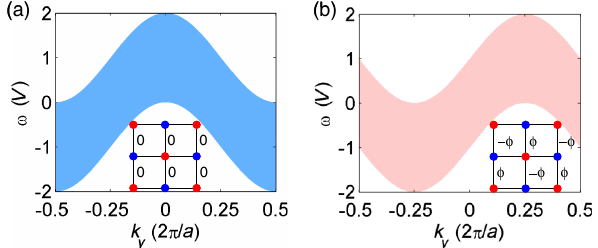
FIG. 3. Projected band diagrams for a modulated square lattice (a) with no gauge field and (b) with an effective gauge field of ϕ ¼ 0 . 5 π . The insers show the lattice configuration with the corresponding modulation phases. shape. Figure 3(a) corresponds to zero gauge field everywhere. In this case, the dispersion relation of the lattice is